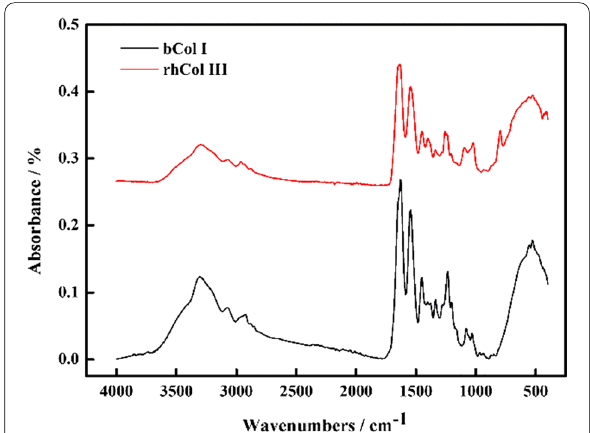
Fig. 3 FTIR spectra of rhCol III and bCol